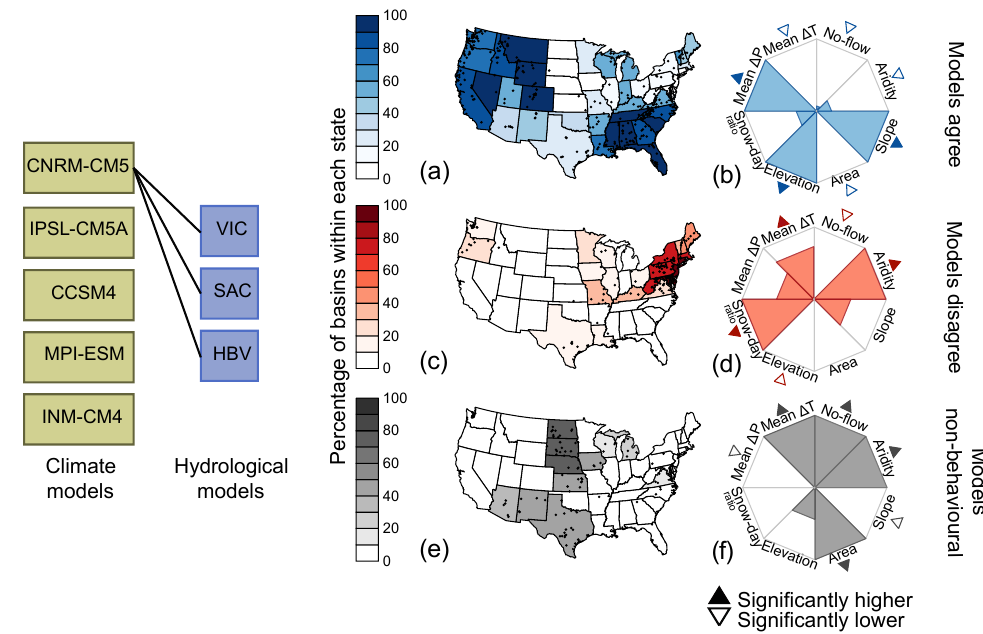
Figure 4. Spatial distribution of the basins in which the three hydrologic models agree on the sign of change in mean annual runoff (a) and disagree on the sign (c) , and of the basins in which all models were non-behavioural for the current climate with observed forcing (e) . The rose plots (b, d, f) show the standardized catchment and climate characteristics for catchments shown in (a) , (c) , and (e) , respectively. In the rose plots, “mean (cid:49)P ” stands for the mean change in precipitation, and “mean (cid:49)T ” for the mean change in temperature. The hydrologic models (VIC: Variable Infiltration Capacity model; SAC: Sacramento Soil Moisture Accounting model; HBV: Hydrologiska Byråns Vatten- balansavdelning model) were forced with CNRM-CM5 projections (Representative Concentration Pathway 8.5). The characteristics in the rose plots have been standardized from 0 to 1, where 0 represents the lowest value of the characteristics for the three displayed groups and 1 the highest value of the characteristics for the three displayed